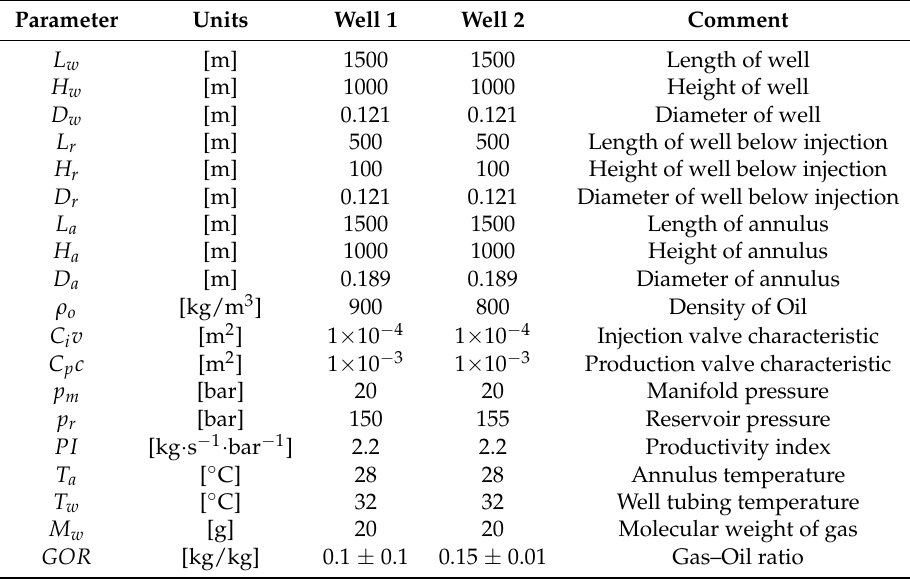
Figure 4. Production network with two gas lifted wells producing to a common manifold. Table 1. List of parameters and their corresponding values used in the